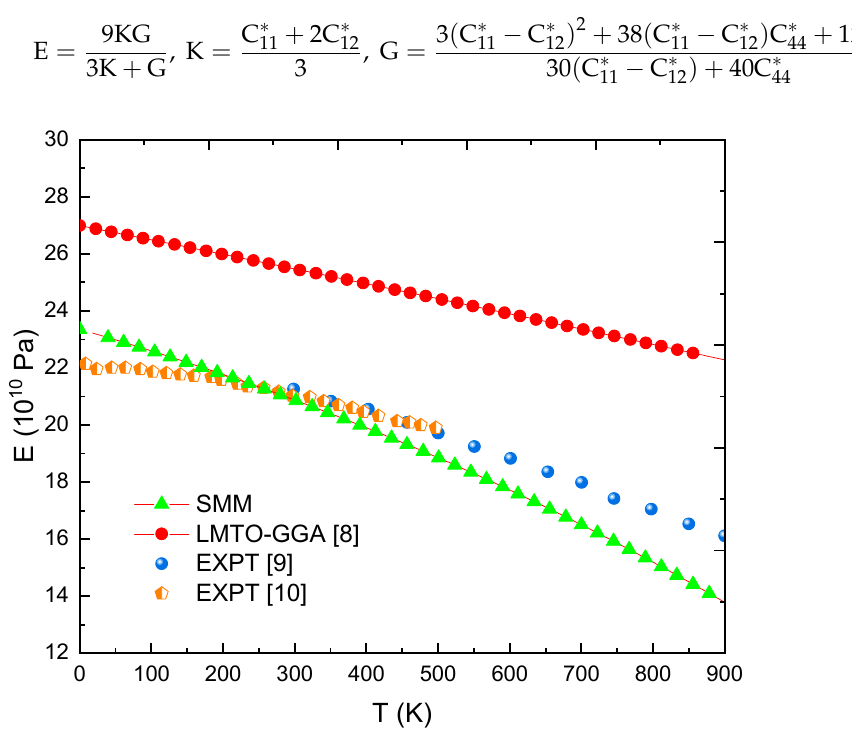
Figure 1. E(T) for Fe at P = 0 was obtained using the SMM, LMTO-GGA [8], and from EXPT [9,10]. K, G, C 11 , C 12 calculations for single Fe metal at different T and p values are illus- trated in Table 2 in comparison with other theoretical and experimental studies. Table 2. C 11 (T,P), C 12 (T,P), K(T,P) and G(P) for Fe.